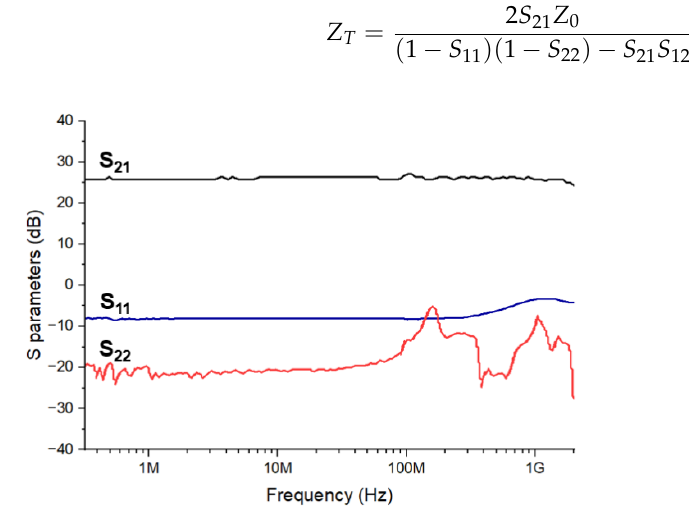
Figure 9. ( a ) Measured I – V curve of the P + /N-well APD and (b) its responsivity.